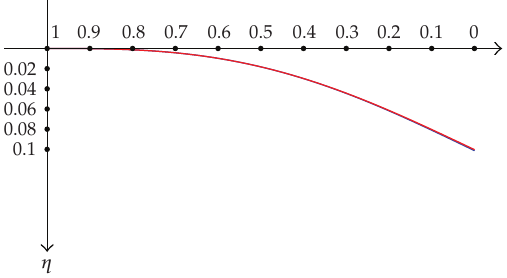
Figure 8: Integral (cid:3) 2.39 (cid:4) numerical, and by formula (cid:3) 2.44 (cid:4) with ε (cid:5) 0 . 1. The plot shall be conveniently oriented; the rod’s clamped end is at the right side, that is, ξ (cid:5) 1, and the load is thought to act